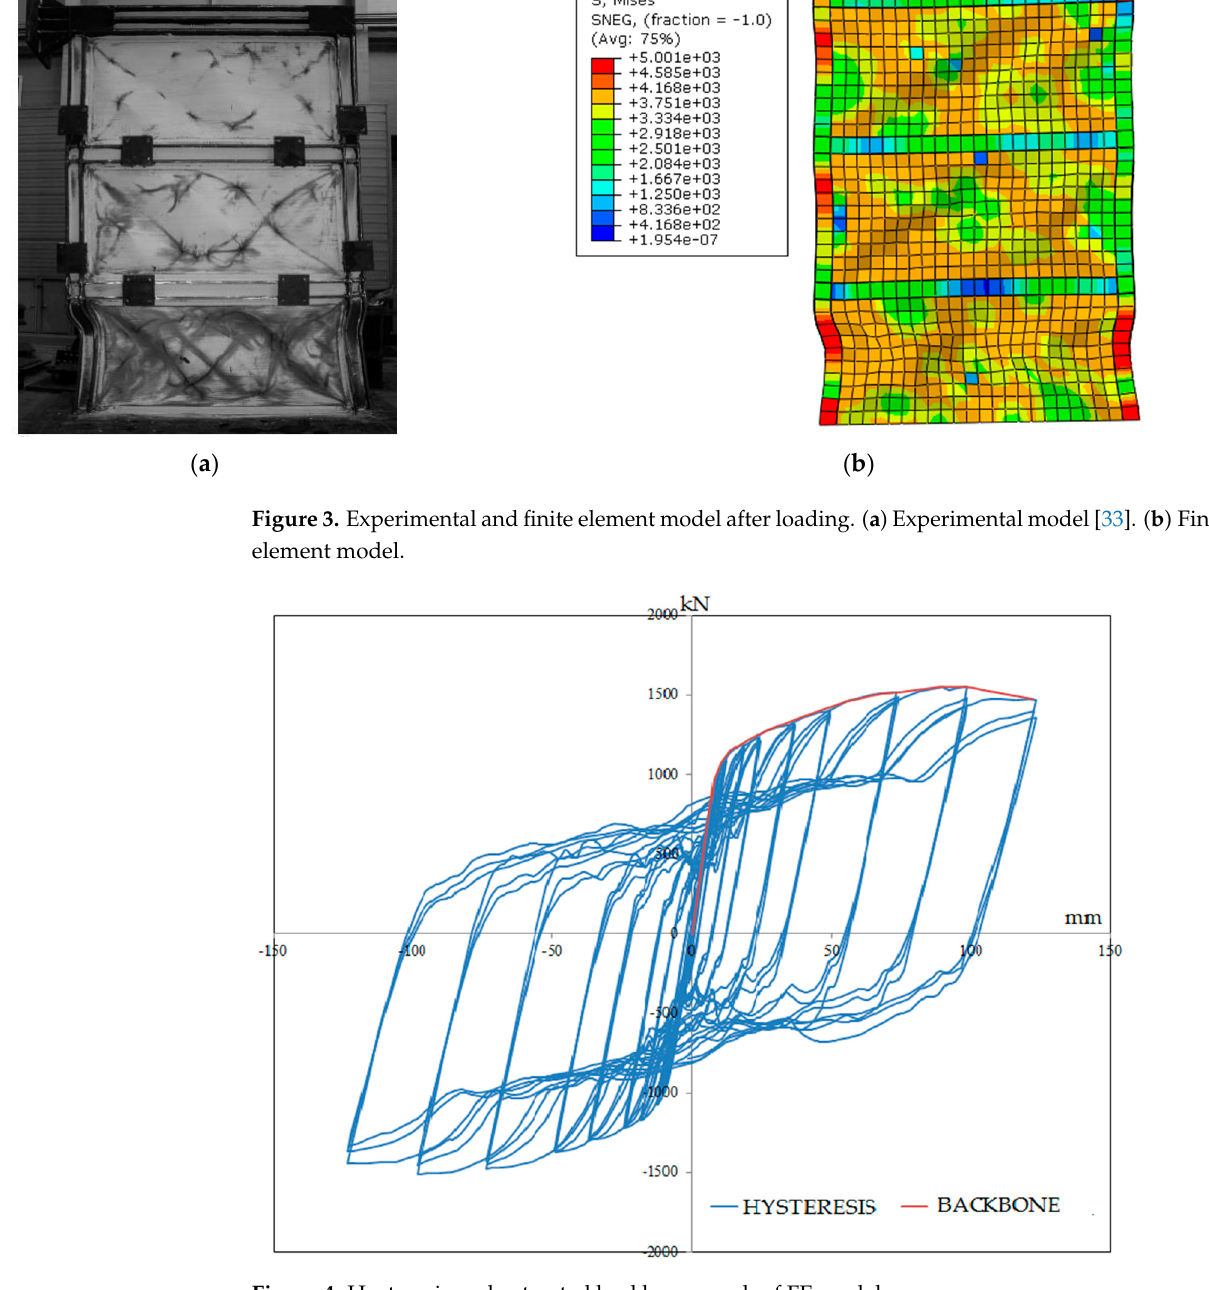
Figure 4. Hysteresis and extracted backbone graph of FE model.